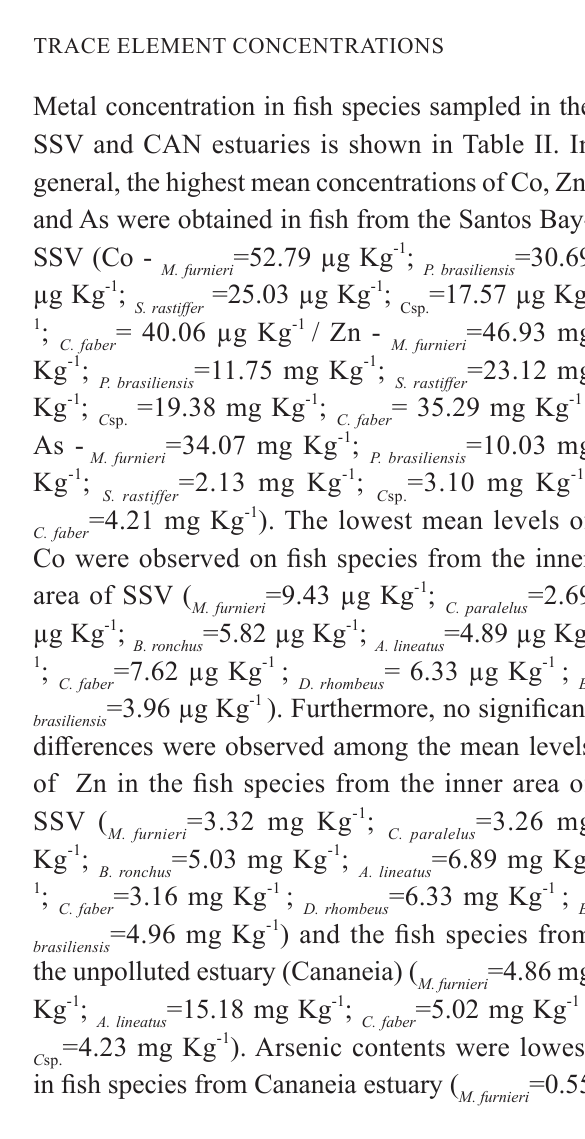
differences were observed among the mean levels